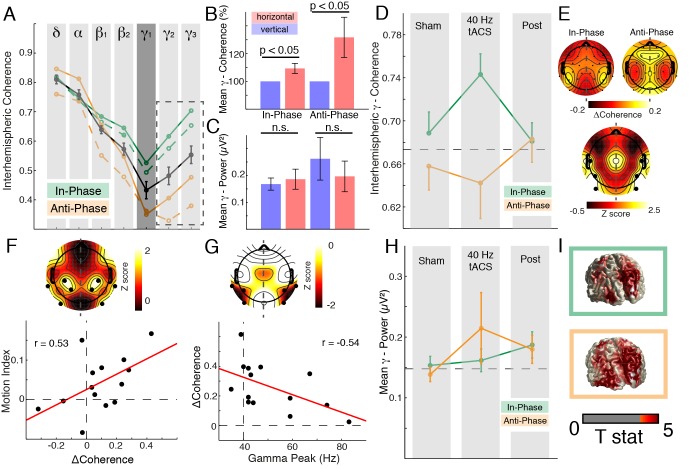
Modulation of interhemispheric coherence during stimulation.(A) Grand mean coherence average over four posterior channel pairs: The solid black line depicts average coherence during sham (mean ± SEM). Notch filtering in the γ1-band was applied to all conditions (dark-grey shaded, estimates were obtained after spectral smoothing and not used for statistical analyses; dashed box highlights utilized frequency bands). Dashed lines indicate vertical motion percepts; solid lines depict horizontal percepts. See also Data S1. (B) Relative γ2/3-coherence increase during the horizontal percept (with respect to the vertical percept) revealed that the binding-related coherence increase was still present during tACS (same conventions as in Figure 2C). (C) Absolute γ2/3-power values indicated that coherence changes were not related to gamma-power changes. (D) Coherence change over time (pair of interest). The black dashed line indicated the mean sham value. See also Data S1. (E) Spatial distribution for the coherence modulation. Upper left: In-phase stimulation. Upper right: Anti-phase stimulation. Lower: The Z-score map indicates a significant difference between in- and anti-phasic tACS located over parieto-occipital electrode pairs. Dots highlight the significant cluster. (F) Cluster-based permuted correlation analysis: A baseline corrected motion index (MI)  =  (MRInPhase − MRShamIn) − (MRAntiPhase − MRShamAnti) was correlated with the baseline corrected ΔCoherence of γ2-coherence values (CohIn-Phase − CohAnti-Phase). Upper panel: The black dots in the topography depict the significant cluster (p = 0.008). Lower panel: Regression line fitted through the mean coherence values as obtained from the cluster test. Dots depict individual subjects. Solid red line depicts the linear regression. (G) Cluster-based permuted correlation analysis indicated that subjects with an individual gamma coherence peak close to the stimulation frequency (40 Hz) exhibit the largest coherence modulation (p = 0.049). (H) Mean gamma power change over time (Data S1). (I) Source reconstruction of gamma activity during in- (green) and anti-phase (orange) stimulation as compared to baseline.